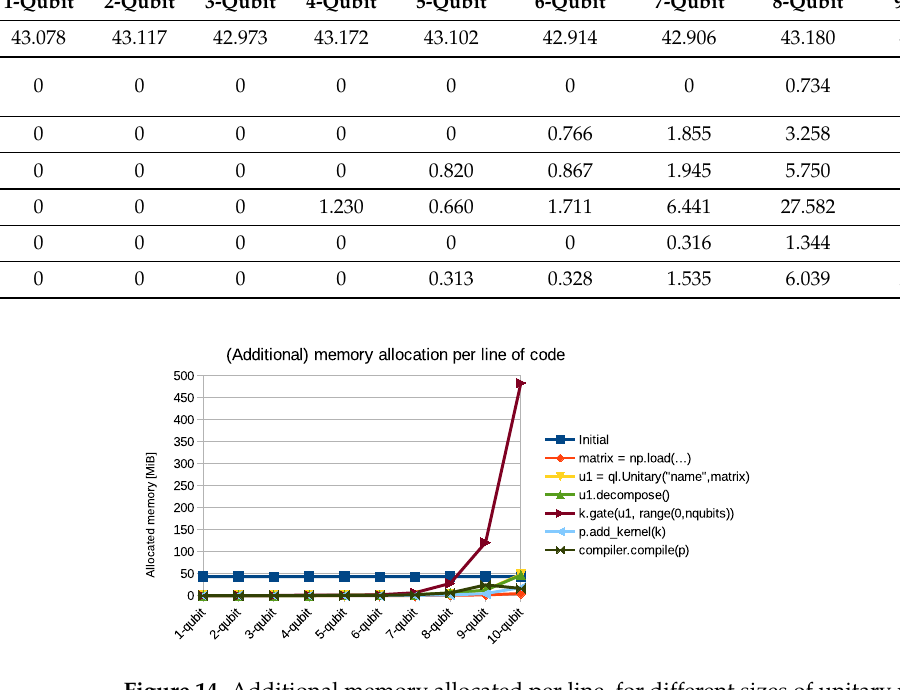
Figure 14. Additional memory allocated per line, for different sizes of unitary